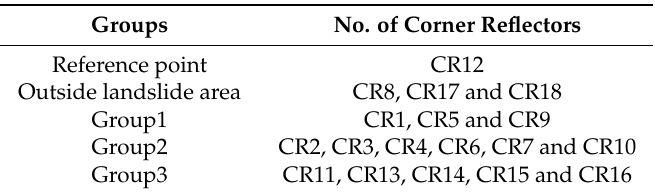
Table 2. Groups of 18 corner